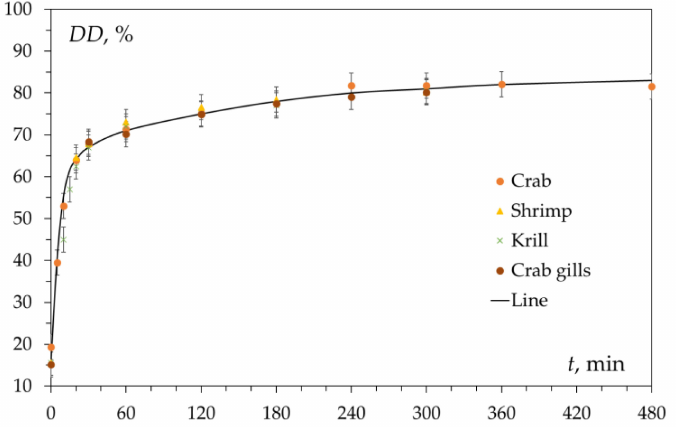
Figure 3. Kinetic curves of deacetylation of chitin obtained from crab shell, shrimp, Antarctic krill, and red king crab gills. Reaction conditions: 50% NaOH; 95 ± 2 ◦ C; DD 0 15–20%. Original figure.